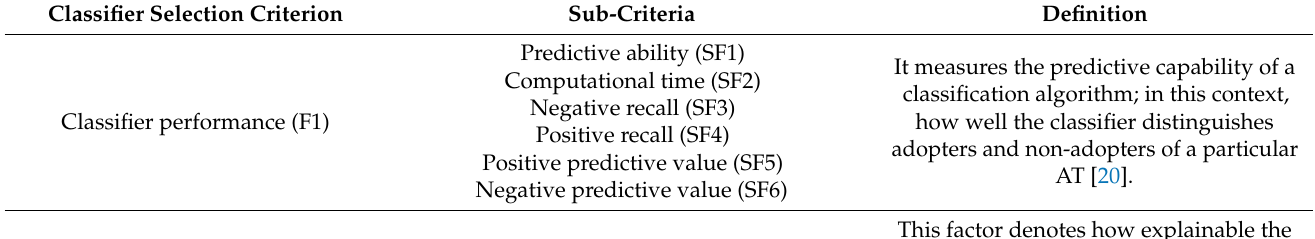
Table 2. Description of classifier selection